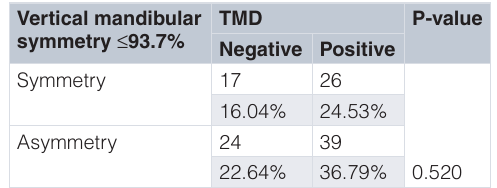
Table 3. The difference in temporomandibular joint disorder (TMD) symptoms based on vertical mandibular